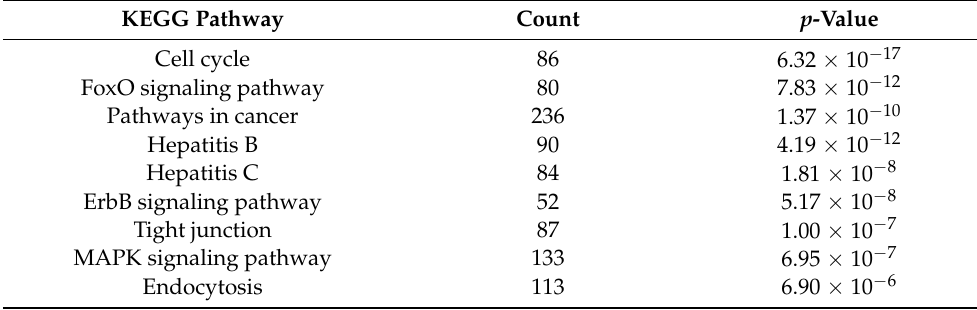
Figure 2. Visualization of core HPI-GWGEN of amplification and saturation infectious stages. The blue and green edges (lines) represent the protein-protein interactions and gene regulations, respec- tively. The numbers of each type of node (protein, receptor, transcription factor, miRNA, lncRNA, and virus) are shown in the figure. ( A , B ) are the core HPI-GWGENs of amplification and saturation infectious stages, respectively. Table 2. The enrichment analysis of KEGG pathways for core HPI-GWGEN of the amplification infectious